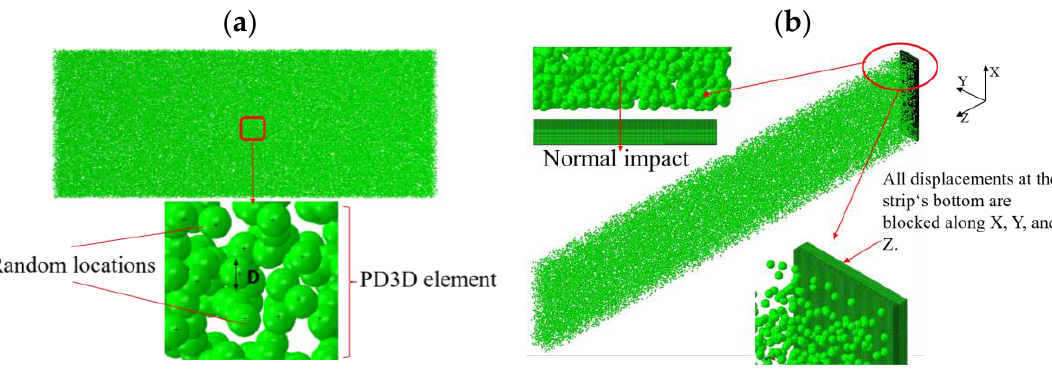
Figure 8. DEM–FEM for shot peening. ( a ) Three-dimensional random shot model. ( b ) Normal impact of the shots in the explicit DEM–FEM model.